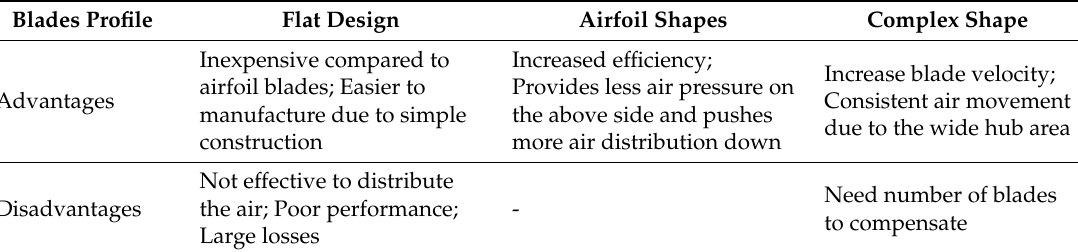
Table 1. Blades design of the monstrous fan. Table 1 . Blades design of the monstrous fan .